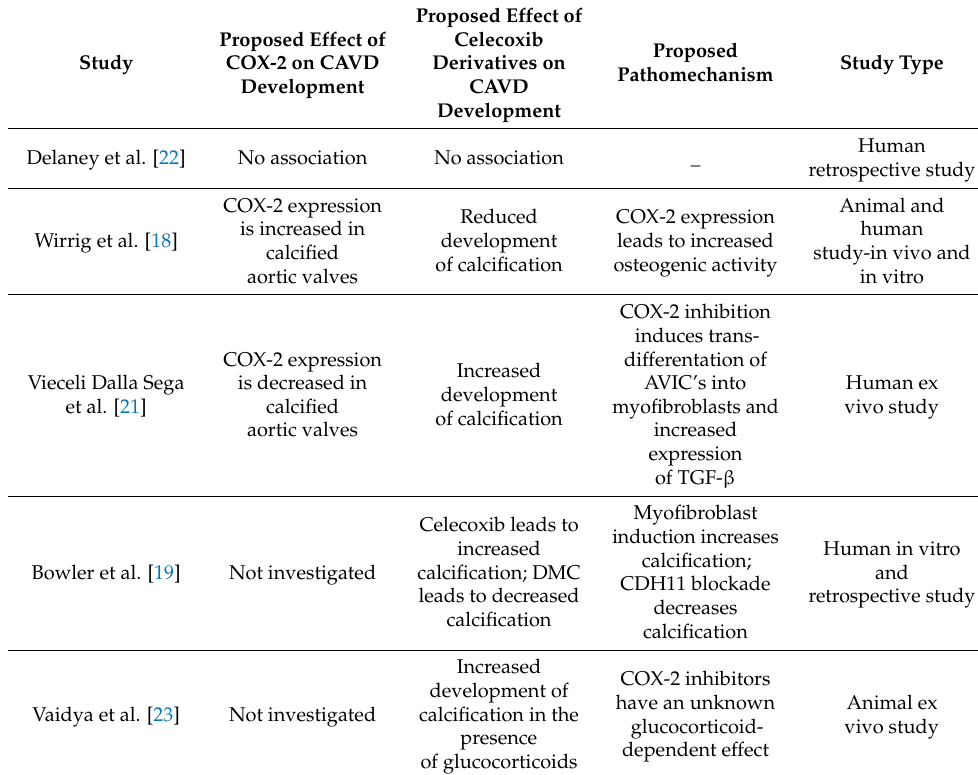
Table 1. A summary of the major findings of recent primary studies that investigated the potential association between celecoxib derivatives and the development of aortic valve calcification [18,19,21–23]. Proposed Effect of Proposed Effect of Celecoxib Proposed Study COX-2 on CAVD Derivatives on Study Type Pathomechanism Development CAVD Development Human Delaney et al. [22] No association No association _ retrospective study Animal and COX-2 expression Reduced COX-2 expression human is increased in development leads to increased Wirrig et al. [18] study-in vivo and calcified of calcification osteogenic activity in vitro aortic valves COX-2 inhibition induces trans- differentation of COX-2 expression Increased AVIC’s into Human ex Vieceli Dalla Sega is decreased in development vivo study et al. [21] calcified myofibroblasts and of calcification aortic valves increased expression of TGF- β Myofibroblast Celecoxib leads to induction increases increased Human in vitro calcification; Bowler et al. [19] Not investigated calcification; DMC and CDH11 blockade leads to decreased retrospective study decreases calcification calcification Increased COX-2 inhibitors development of have an unknown Animal ex Vaidya et al. [23] Not investigated calcification in the glucocorticoid- vivo presence dependent effect of glucocorticoids